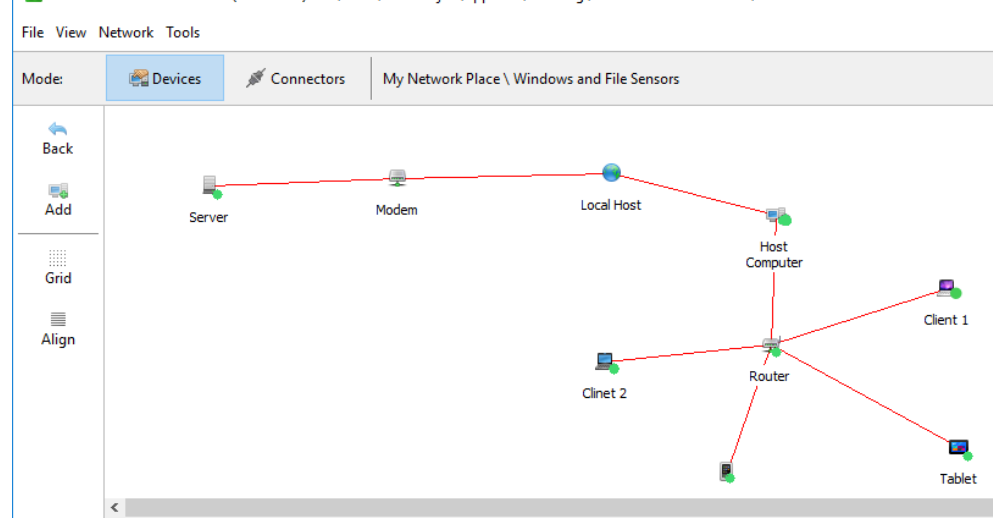
Figure 6. Network Monitor.